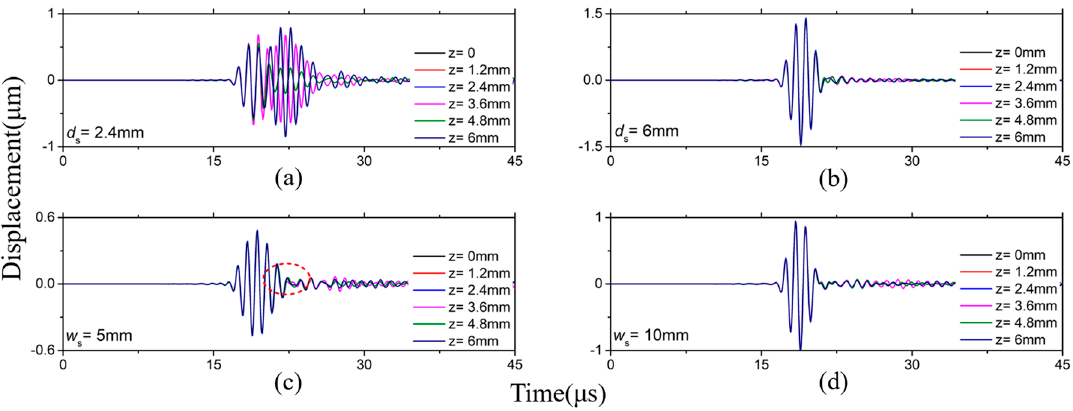
Figure 6. Waveforms in 6 mm thick waveguide bars: ( a ) w s = 25 mm, d s = 2.4 mm; ( b ) w s = 25 mm, d s = 6 mm; ( c ) w s = 5 mm, d s = 6 mm; ( d ) w s = 10 mm, d s = 6 mm.